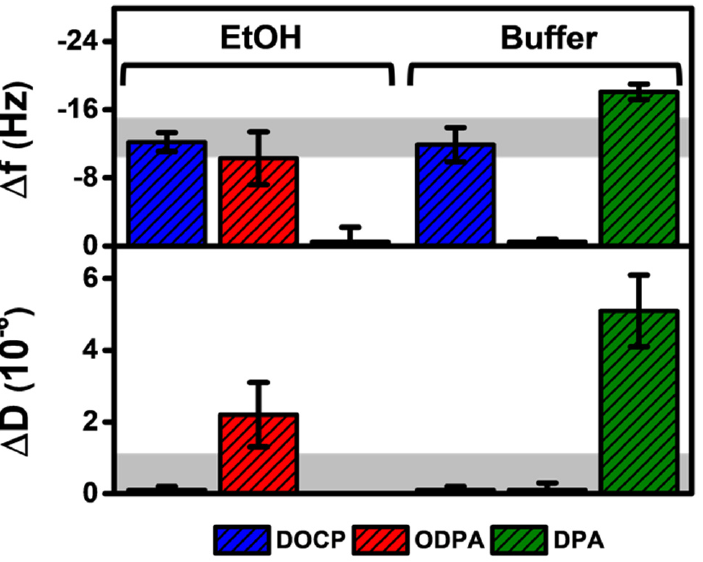
Figure 3. Summary of QCM-D measurement responses corresponding to DOCP, ODPA, and DPA attachment on TiO 2 surfaces. The final ∆ f and ∆ D shifts are reported for molecular deposition in ethanol and buffer conditions, and the data are presented as the mean ± standard deviation, which were computed from n = 3 runs. The shaded regions correspond to the typical measurement values for a complete monolayer.